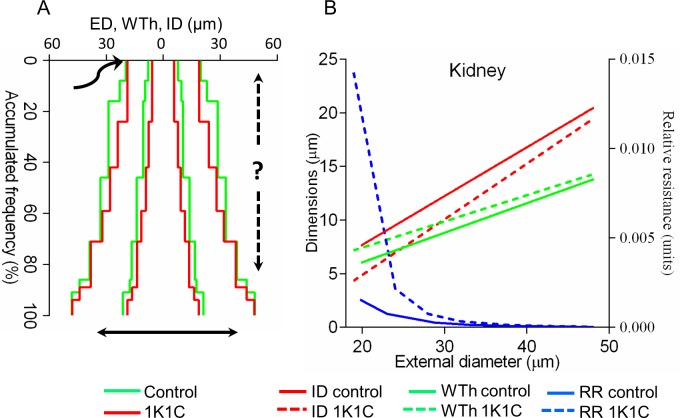
Considerations for arterial remodeling assessment.(A) The profile of hypertensive (red) renal arteries was superimposed on the control (green). The starting point (the curved arrow) is uncertain: inward–outward remodeling (the solid double arrow) is well known, while proximal-distal shifting (the dashed arrow) is unacknowledged. Uneven accumulated frequencies displaced interval values irregularly. Complementary graphs are in S5 Fig. (B) Linear regression lines of renal terminal arteries demonstrated the decreased internal diameter (ID) and increased wall thickness (WTh) in hypertension. The slopes were different (P<0.0001). ED–external diameter; RR–relative resistance. Complementary graphs are in S6 Fig.